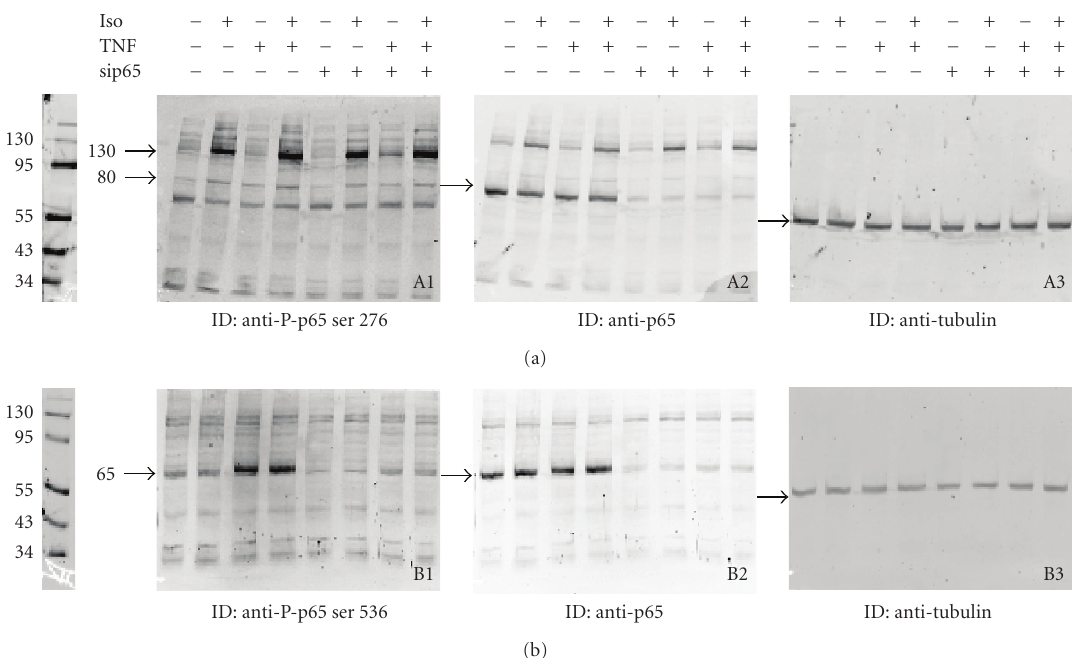
Figure 2: The Cell Signaling no. 3037 anti-P-p65 Ser276-immunoreactive band persists in cells where p65 is silenced via an siRNA approach. 1321N1 cells were transiently transfected with control or p65 siRNA as described in Section 2. Cells were induced for 90 min with TNF- α (2000IU/mL), iso (10 μ M), or a combination of both stimuli. Presence of Ser276-phosphorylated p65 in cell lysates was analysed by Western Blot using Cell Signaling no. 3037 (A1). 130 and 80 kDa immunoreactivities are indicated by arrows. Western Blot to detect anti-P-p65Ser536 (65kDa arrow) was performed on the same lysates (B1). Blots A1 and B1 were extensively washed and reprobed with anti-p65 to investigate e ffi ciency of p65 knock-down. Anti-p65 detected bands are marked with arrows (A2, B2). Finally, blots were reprobed with anti-tubulin to check loading e ffi ciency. Anti-tubulin-detected bands are marked with arrows (A3, B3).